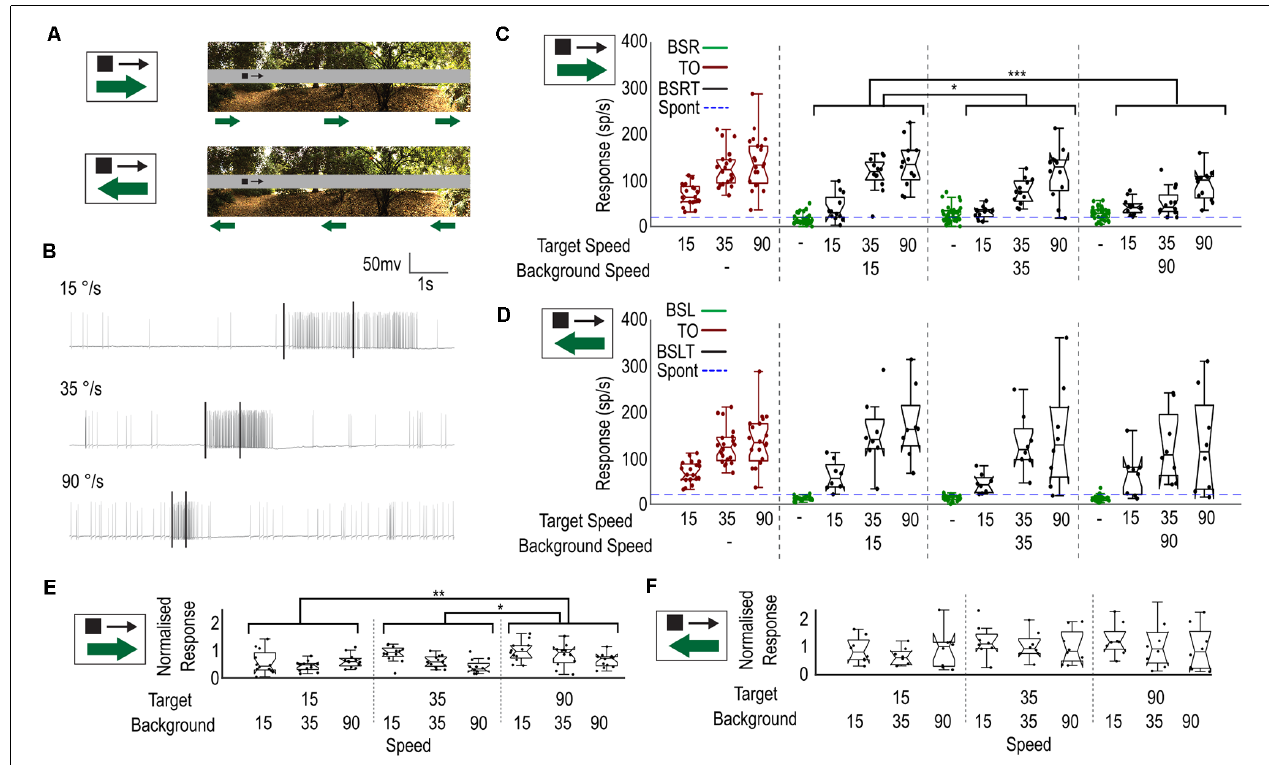
FIGURE 5 | Velocity of the background influences the selection of moving targets. (A) Stimulus. A small black target of three chosen speeds (15 ◦ /s, 35 ◦ /s, 90 ◦ /s) moves while the background moves independently left or right at one of three chosen speeds (15 ◦ /s, 35 ◦ /s, 90 ◦ /s). (B) Three raw traces of varying target velocities showing the difference in response and time-course. Black bars indicate an analysis window of equal size (50 ◦ ). (C) Box plot showing CSTMD1 responses over the analysis window, for the image conditions (target only—red, background only—green, target and background—black) across combinations of target and background velocities. This includes three target-only velocities, three background only velocities and nine target speed and background speed combinations (all in the preferred direction). Target response is more robust when the target moves as fast, or faster than the background. (D) as (C) but with the background motion opposite to the target motion. Background speed has little impact on target responses. (E) Normalized Target with Background (BSRT) responses for rightward moving background. Responses normalized by equivalent target-only response. (F) As (E) for leftward moving backgrounds